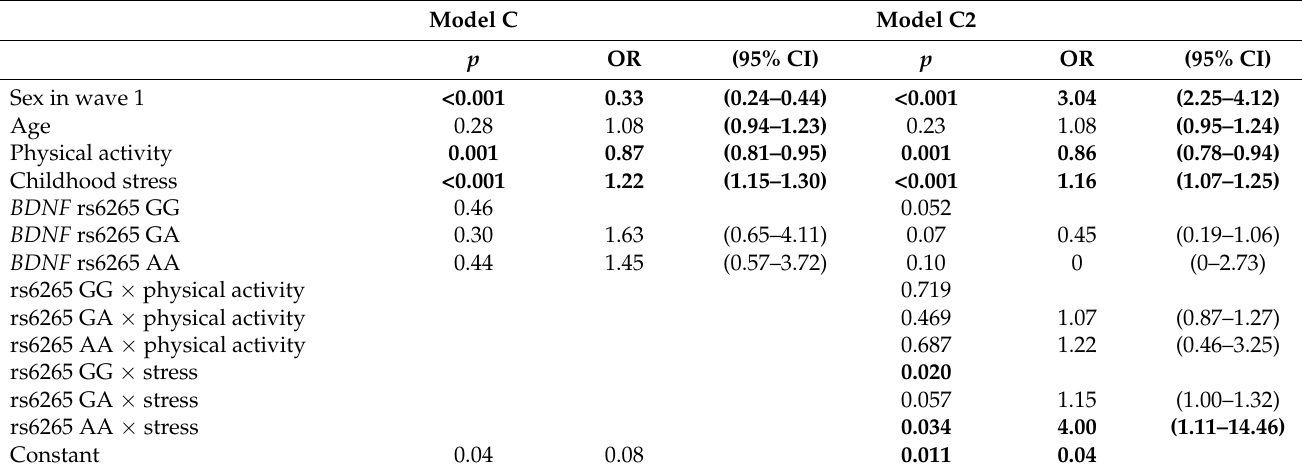
Table 3. Binary logistic regressions exploring the influence of the interactions between BDNF rs6265 and physical activity and between BDNF rs6265 and childhood stress on depressive symptoms in wave 2.